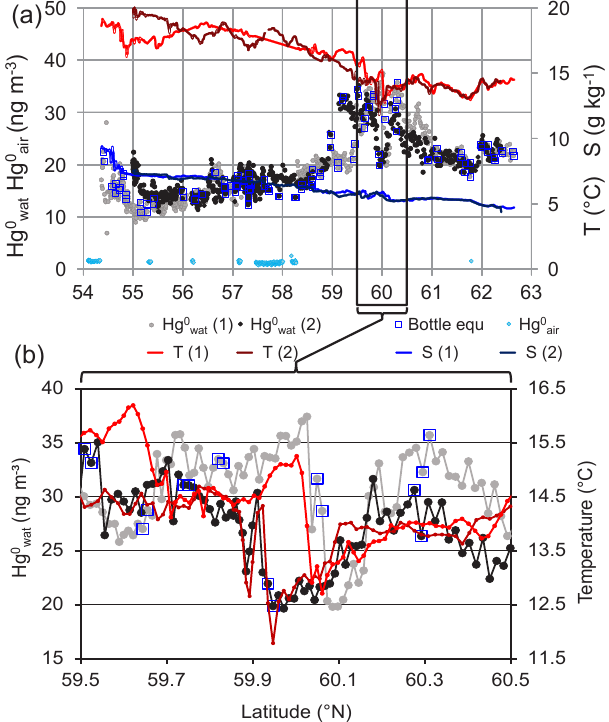
Figure 3. Hg 0 concentration, temperature ( T ), and salinity ( S ) data obtained from surface water measurements in July 2013 along a northward (grey, red, blue) and southward (black, dark red, dark blue) transect, respectively. (a) Data for the whole campaign and (b) Hg 0 wat and temperature in the Åland Sea area only. Bottle equili- brator measurements are indicated by blue open squares. Hg 0 atmo- spheric measurements are given as light blue diamonds in panel (a) for